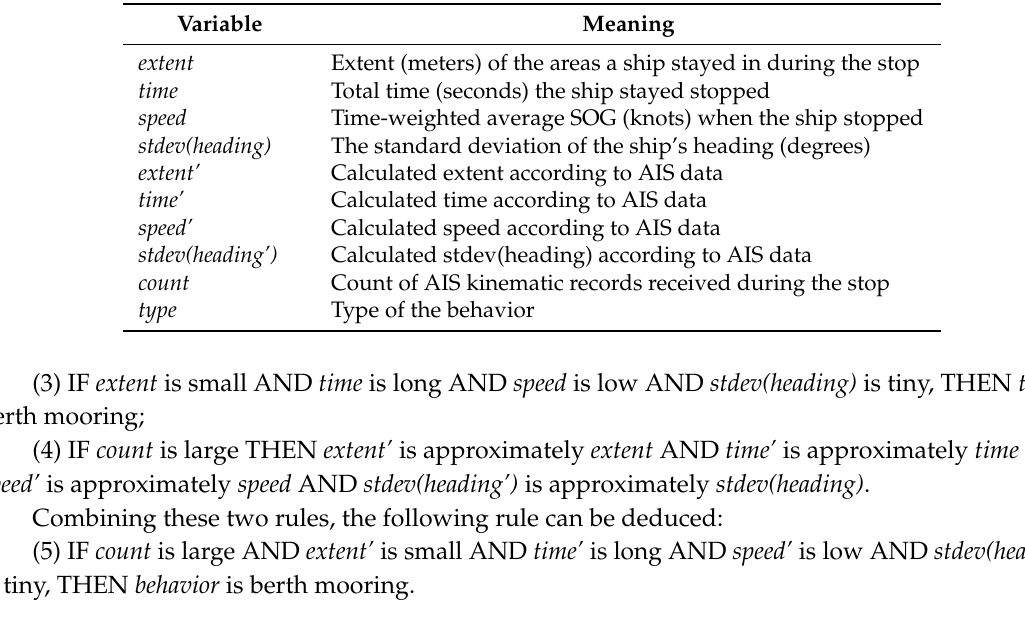
Table 3. Annotations of variables in fuzzy